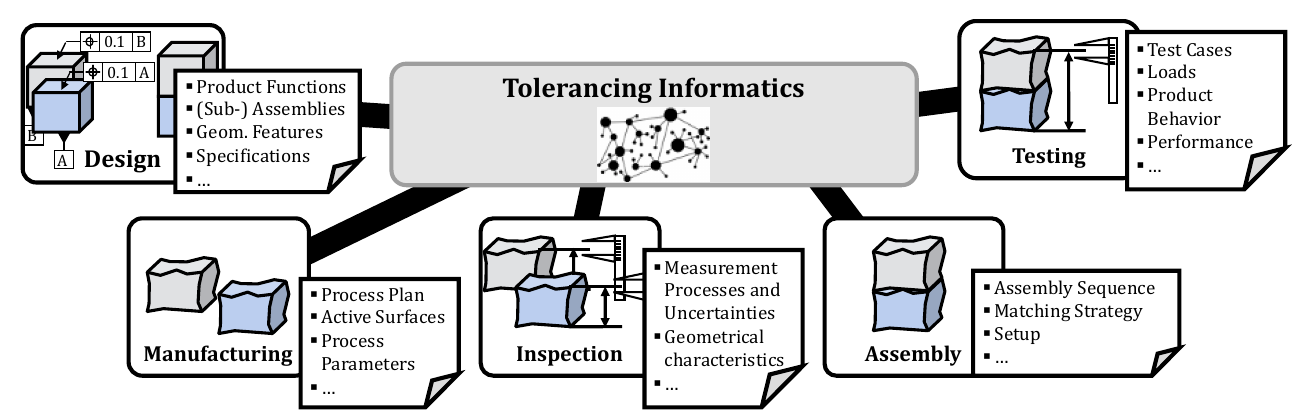
Figure 2. Tolerancing informatics as a seamless link between all activities in geometrical variations management.